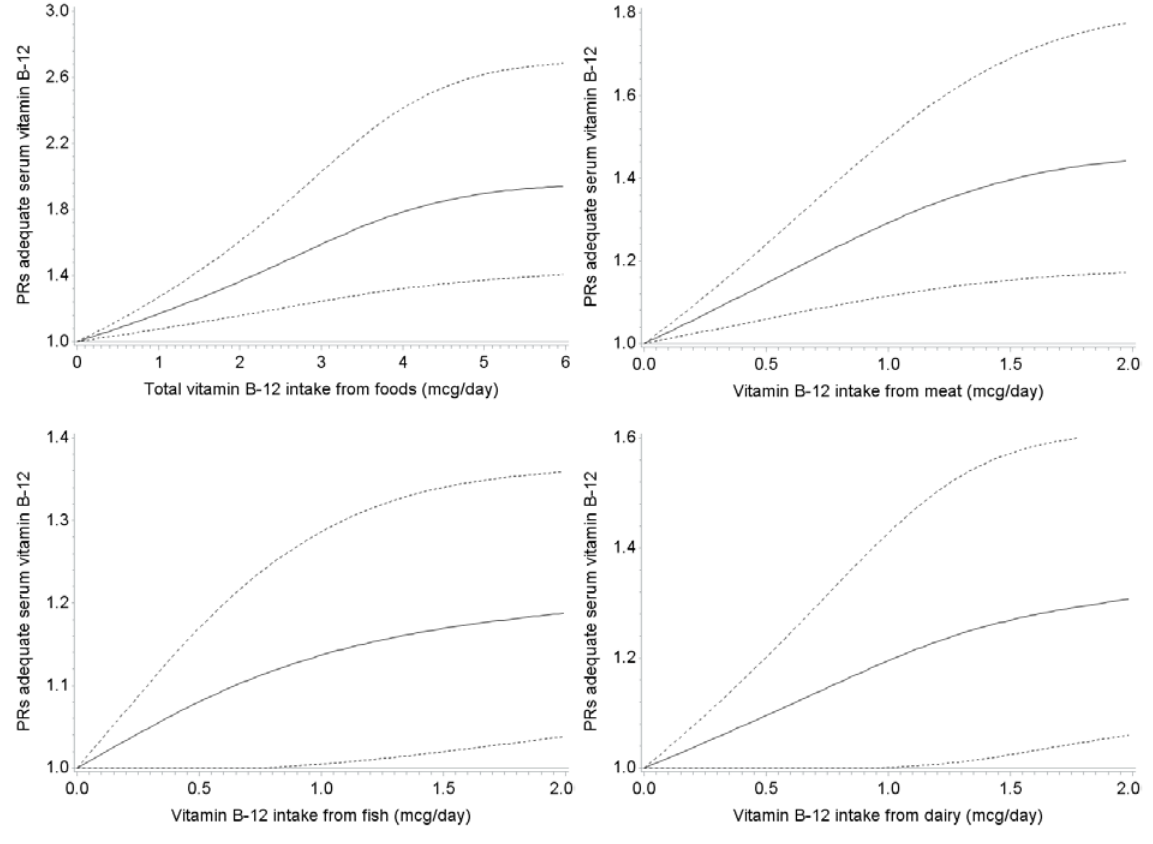
Figure 1. Associations between vitamin B-12-intake from different food sources with serum vitamin B-12-concentations ≥ 200 pmol/L, obtained by spline regression with three knots located at 1st, 5th, and 9th decile. Dotted lines represent 95% confidence intervals. Prevalence ratios were adjusted for age, sex, BMI, education, alcohol intake, physical activity level, smoking, creatinine, total energy intake, and intake of other vitamin B-12-containing food items. P for non-linearity was 0.003 for total vitamin B-12 intake; 0.002 for vitamin B-12 intake from meat; 0.16 for vitamin B-12 intake from fish and shellfish; and 0.34 for vitamin B-12 intake from dairy. P for linearity was 0.19 for vitamin B-12 intake from eggs; 0.06 for vitamin B-12 intake from milk; 0.94 for vitamin B-12 intake from yogurt; 0.44 for vitamin B-12 intake from cheese (data not shown).